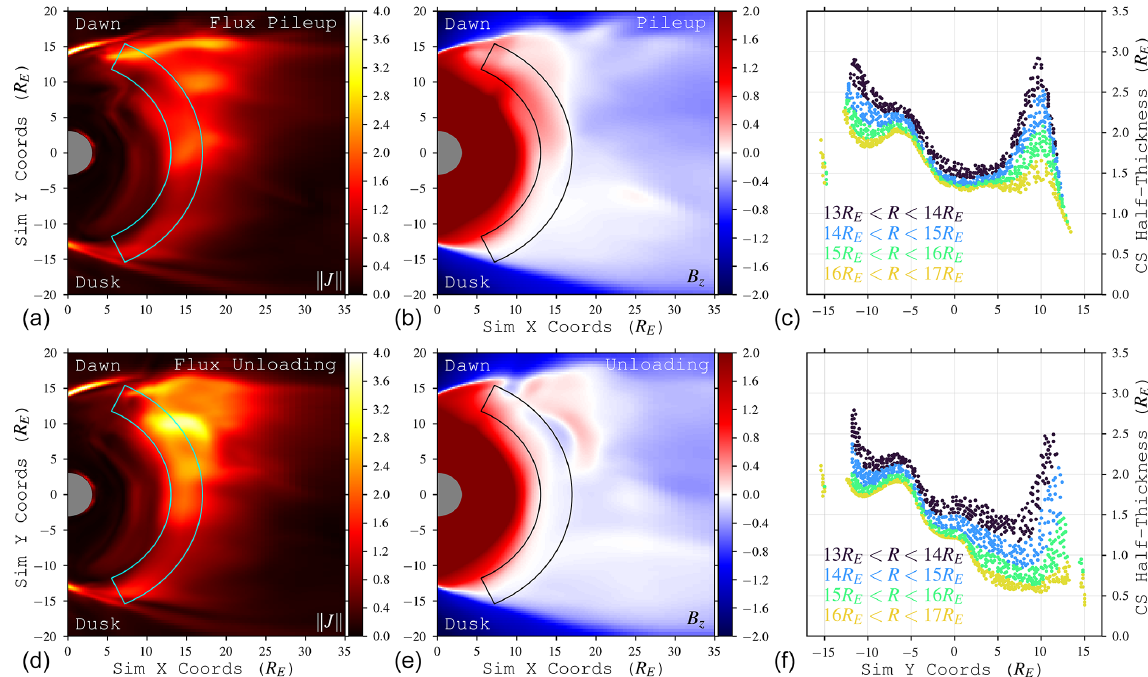
Figure 9. Cross-comparison of current sheet density magnitude (a, d) , current sheet B z flux pileup ( b, e ; same parameters as Fig. 5) and sampled thicknesses (c, f) during (a, b, c) and after (d, e, f) a global dipolarization event. Current sheet fits are sampled from the area within the wedges (13 R E <R < 17 R E ). The current sheet is thick where the B z flux has piled up and thin where the flux has been unloaded. There is a 2 . 25 t 0 ≈ 2 . 4min time difference between the snapshots of the top and bottom rows.